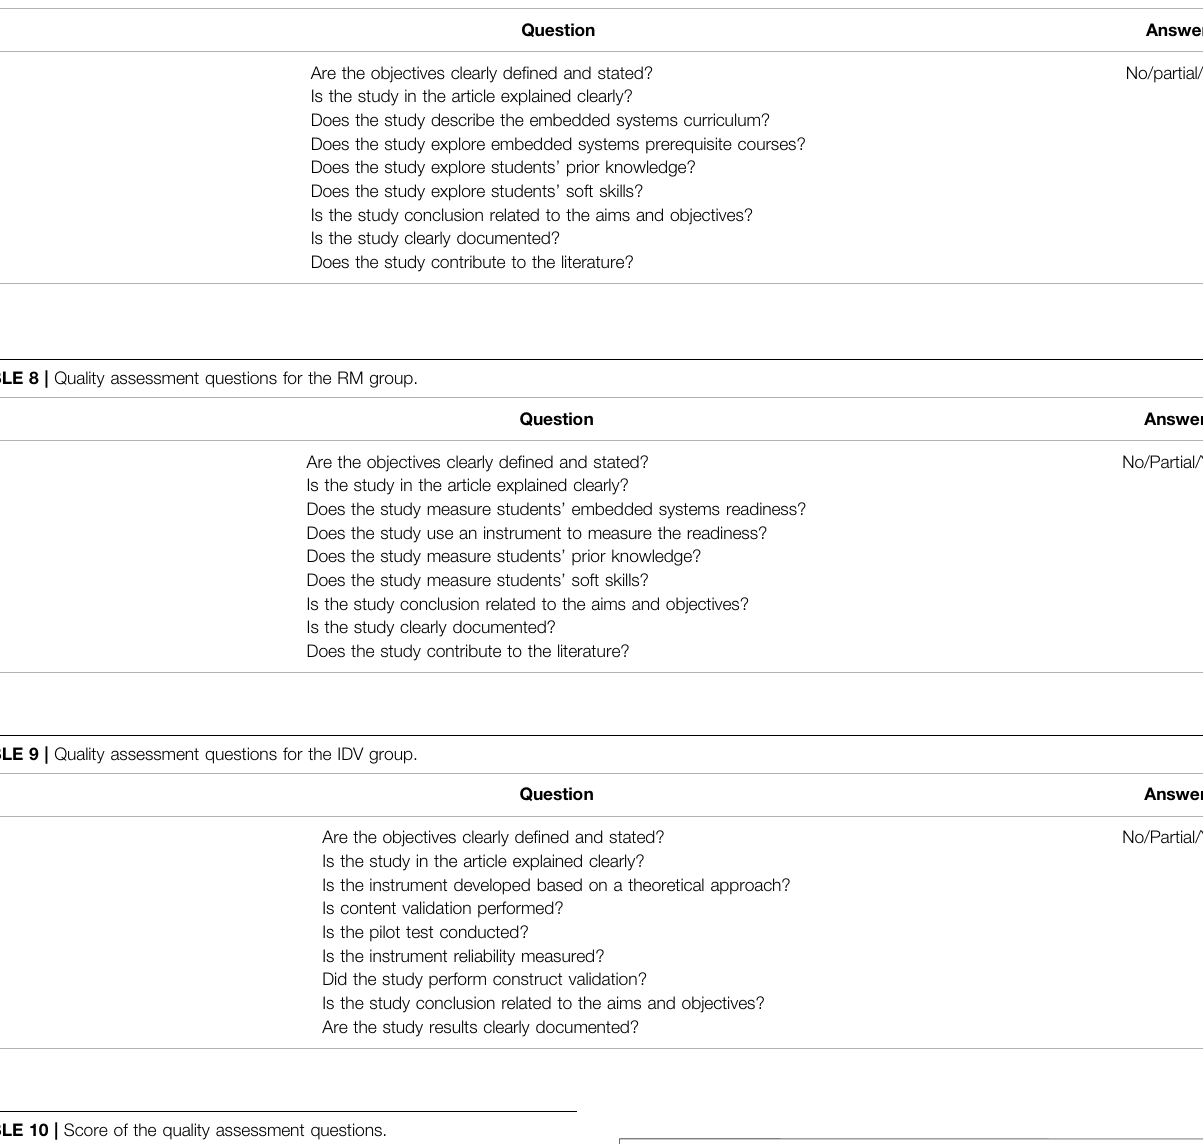
TABLE 7 | Quality assessment questions for the ES group.